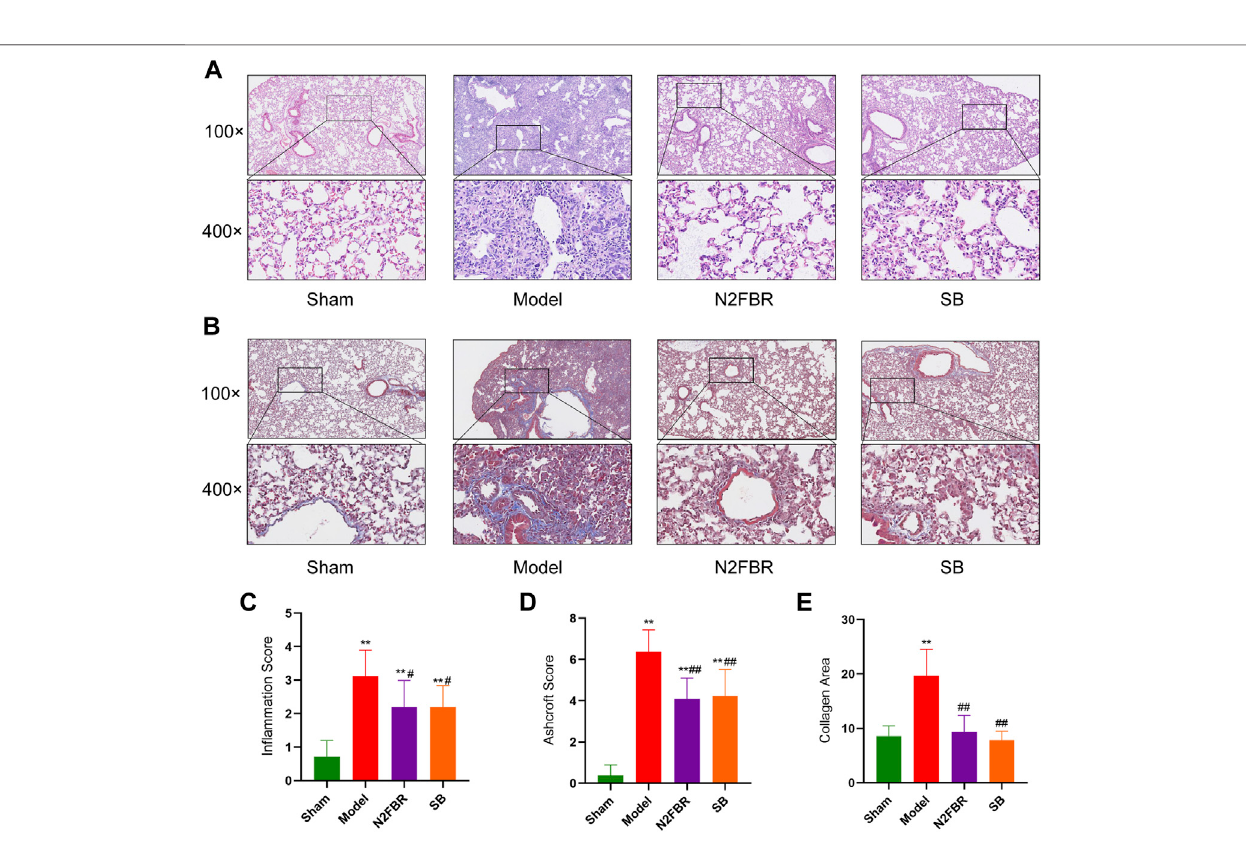
FIGURE 2 | N2FRB alleviated BLM-induced pulmonary fi brosis. (A – B) Representative images of HE staining, MASSON staining. (C – E) Quantitative analysis of AlveolitisscoreandAshcroftscorebasedonHEstainingandcollagenareabasedonMASSONstainingassays.DatawereanalyzedusingonewayANOVA(Mean±SD): ** p < 0.01 compared with the sham group; # p < 0.05, ## p < 0.01, compared with the BLM